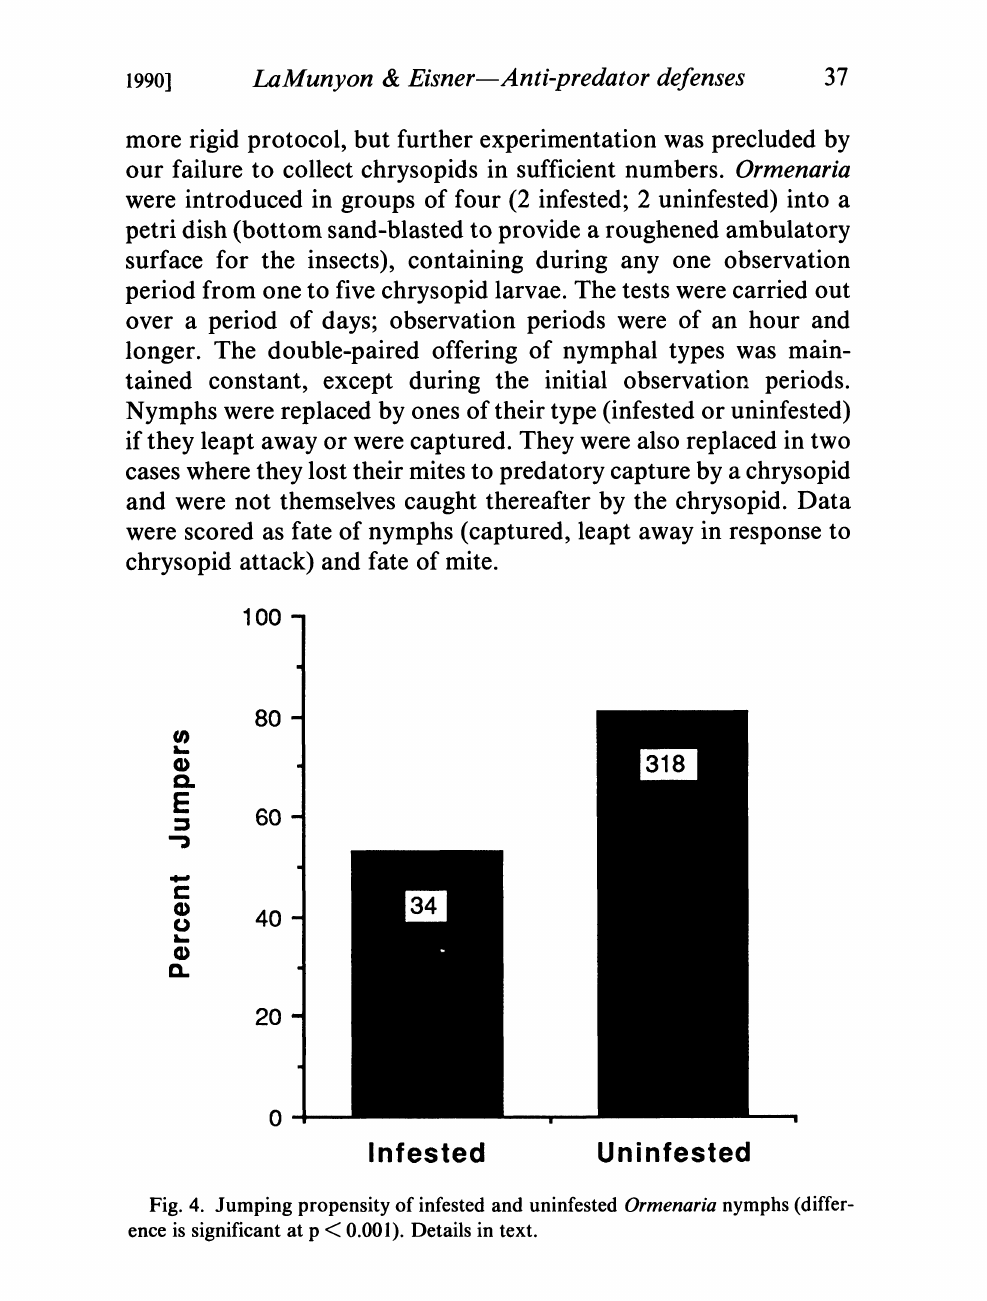
Fig. 4. Jumping propensity of infested and uninfested Ormenaria nymphs (differ- ence is significant at p < 0.001). Details in